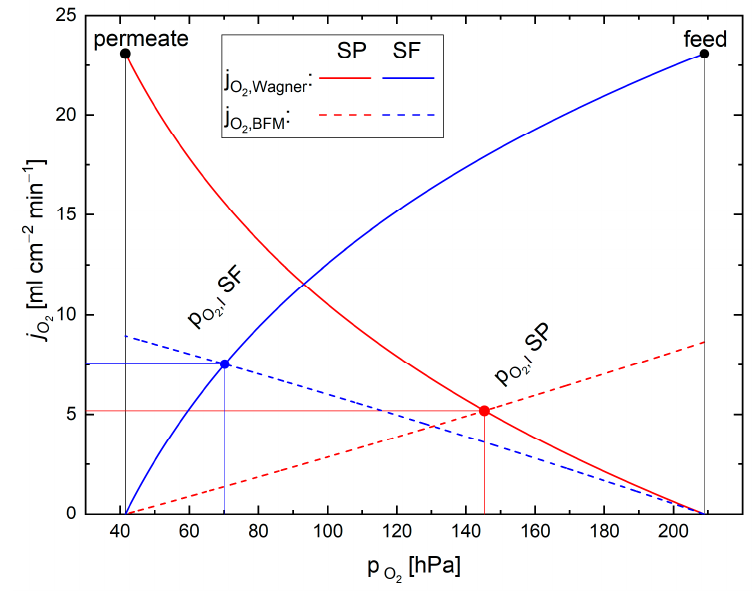
Figure 2. Flux vs. partial pressure curve and resulting flow in membrane and support for support on feed side (SF) and support on permeate side (SP) modes for the example of BSCF. The resultant flux through the entire system as well as the partial pressure at the interface can be seen at the intersection of the respective curves. For the calculation of the fluxes, one pressure is kept constant while the other is varied towards the feed or permeate pressure depending on the operation mode (Wagner or